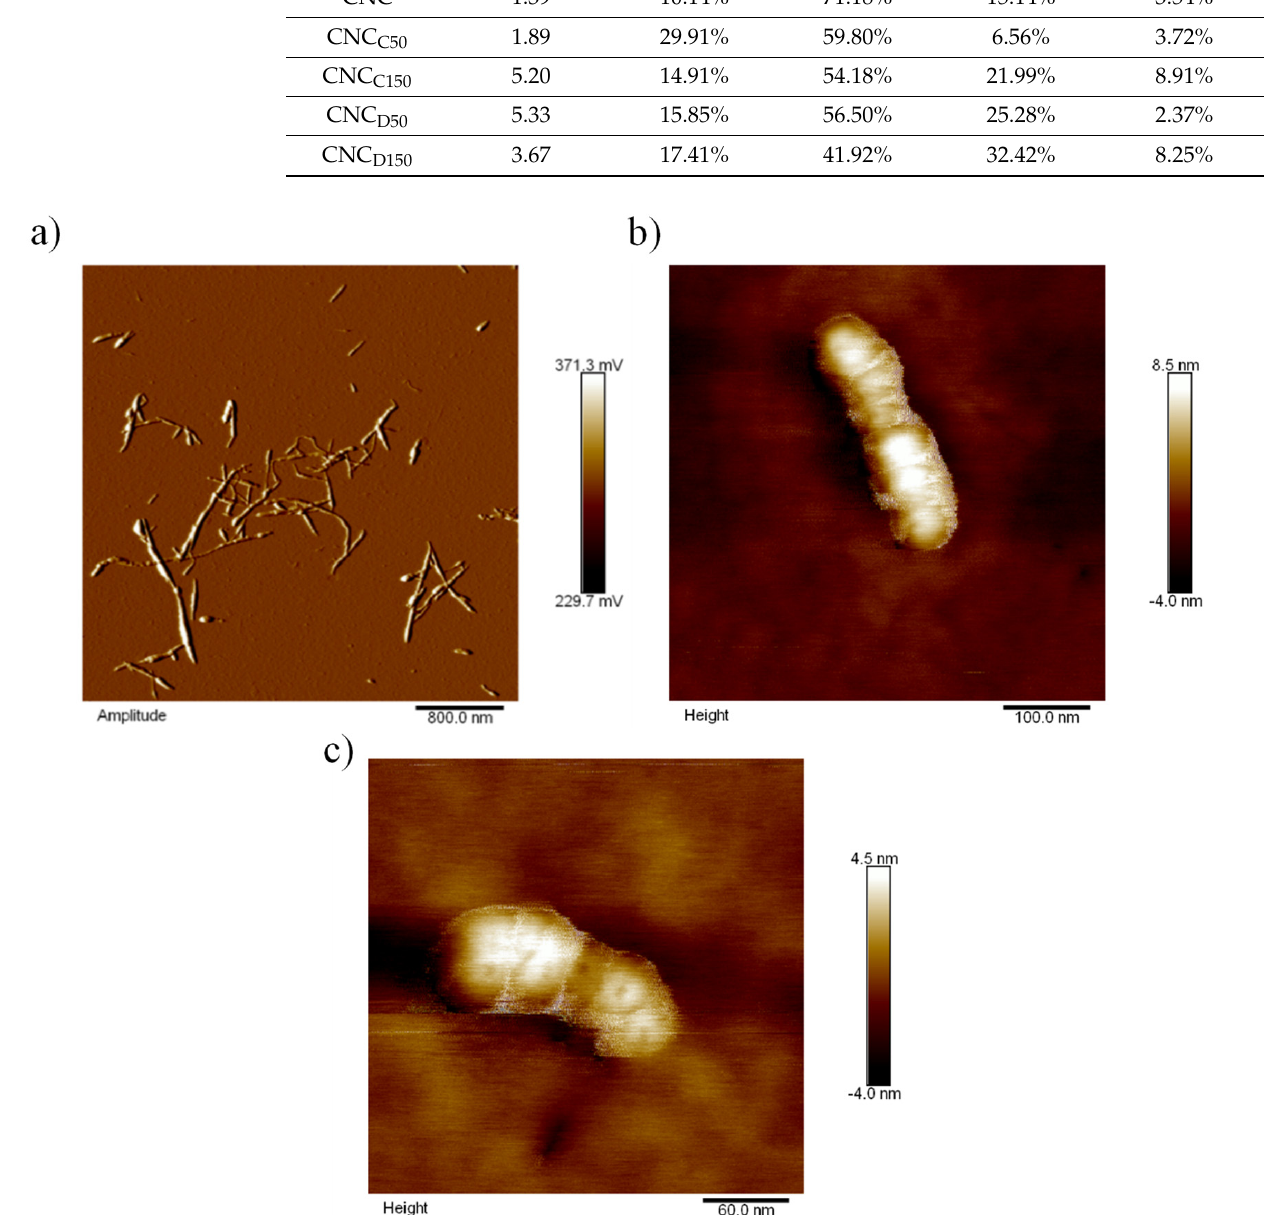
Figure 6. Micrographs obtained by AFM of pristine ( a ) and 150 W ε -caprolactone-modified cellulose nanocrystals ( b , c ). Micrographs were taken at different magnification to show the size of the neat nanoparticles and the influence of the surface treatment.